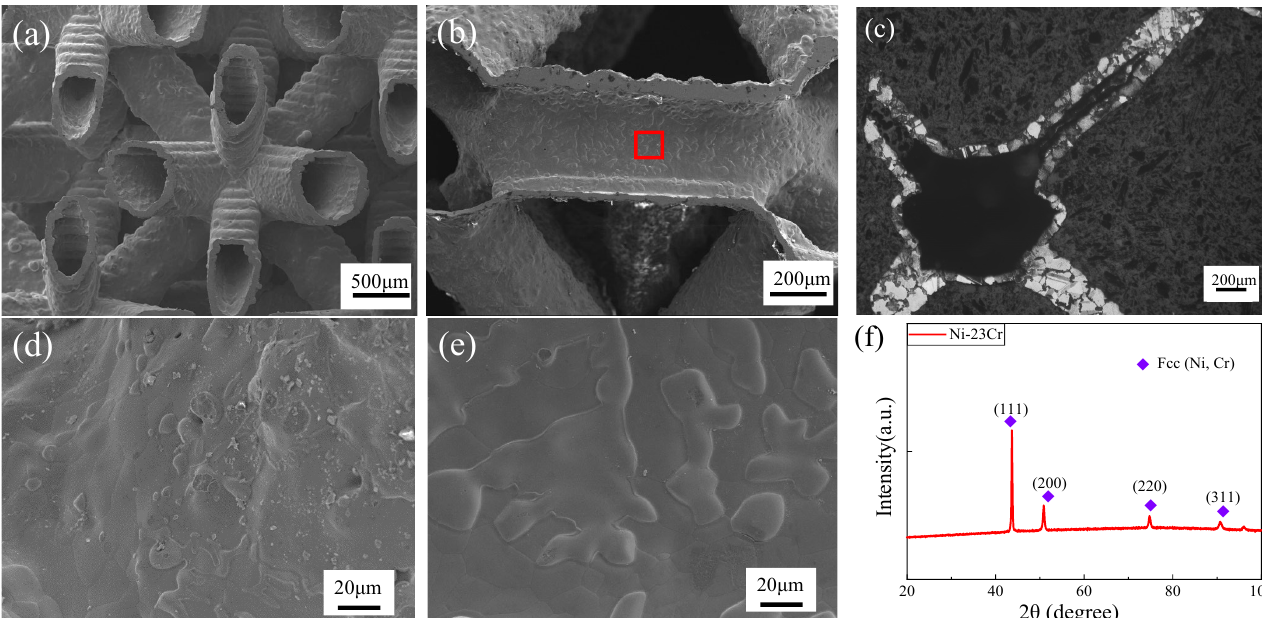
Figure 3. SEM micrographs of ( a , d ) the outer surface of the NiCr lattice and ( b , e ) the inner surface of the NiCr lattice; ( c ) optical micrographs of the etched cross section of a NiCr lattice strut; ( f ) XRD diffraction spectrum.